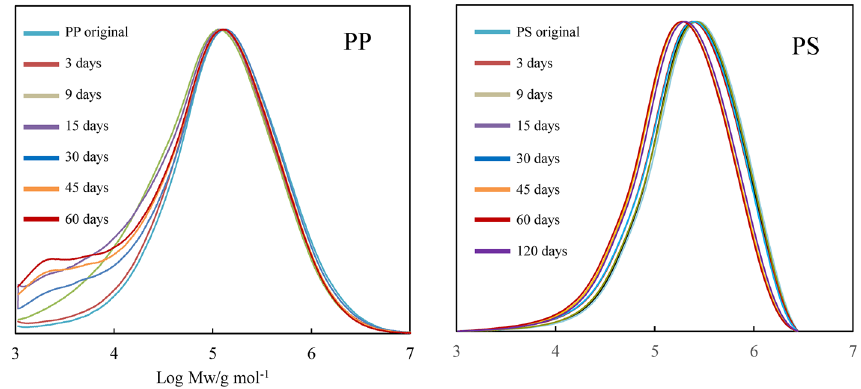
Figure 4. PP and PS differential molecular weight distribution curve changes vs degradation time.